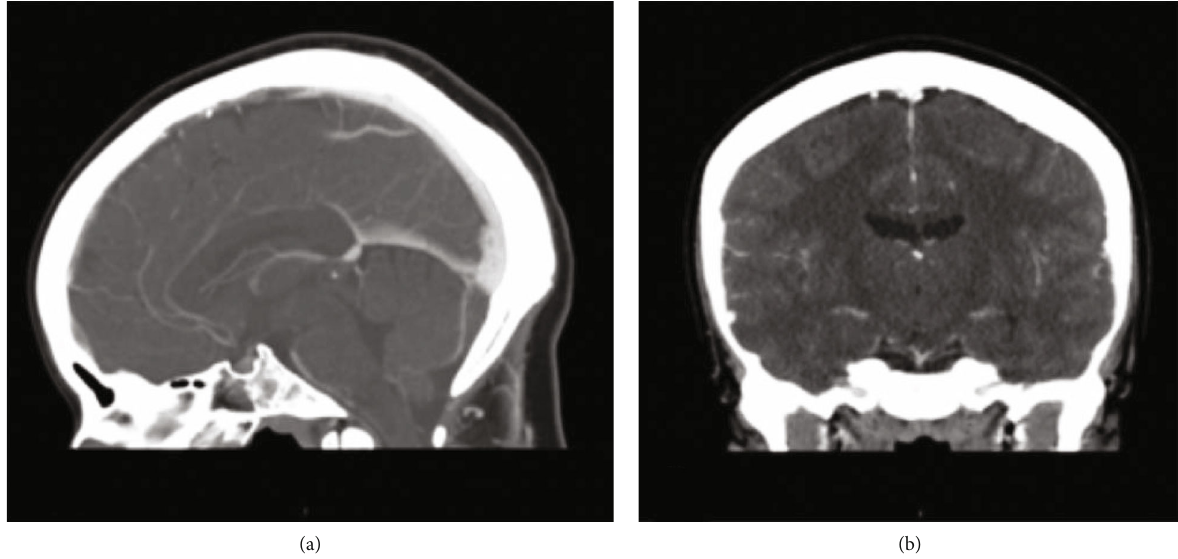
Figure 2: (a) CT venogram with sagittal images resolution of fi lling defects. (b) Coronal images with resolution of fi lling